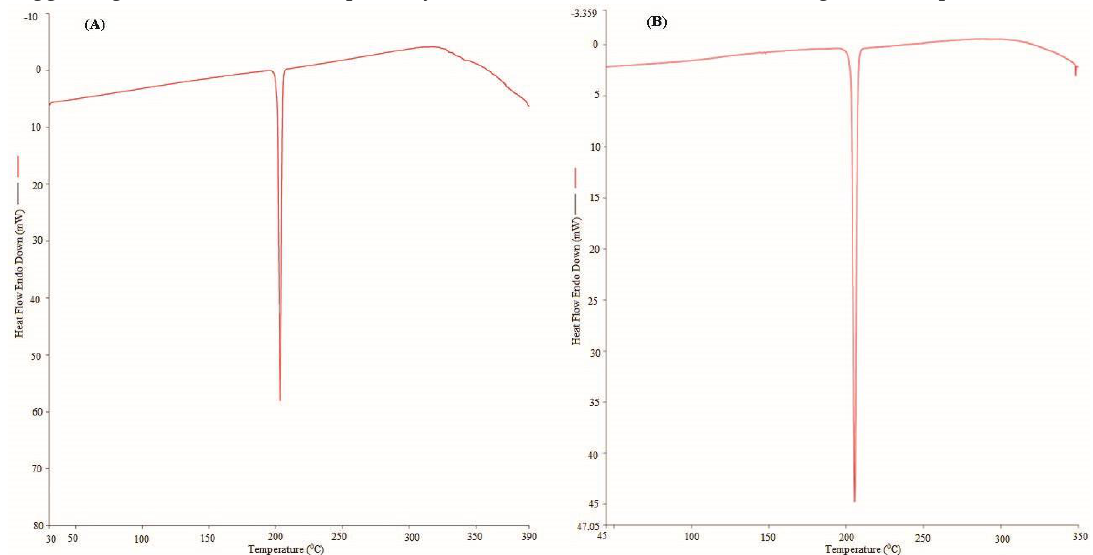
Figure 2. The DSC spectra of ( A ) pure PPD and ( B ) equilibrated PPD; equilibrated PPD was recovered from methanol after slow evaporation.